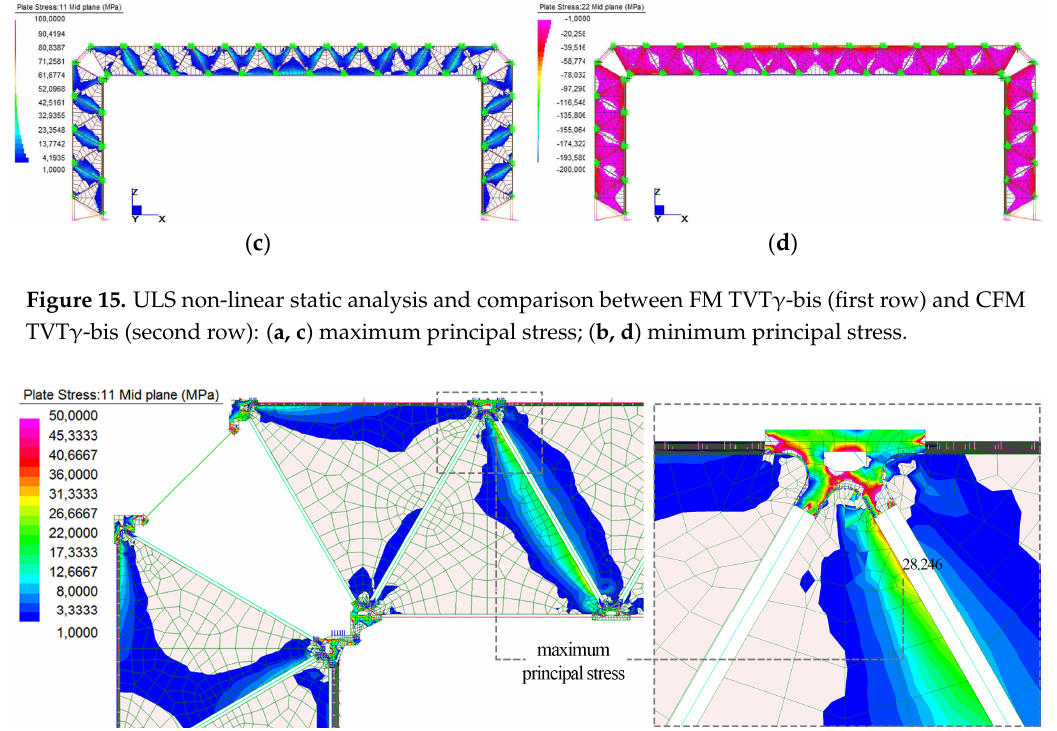
Figure 16. Details of the maximum principal stress in the FM TVT γ‐ bis. The peak value is below the strength of glass from Equation (1).